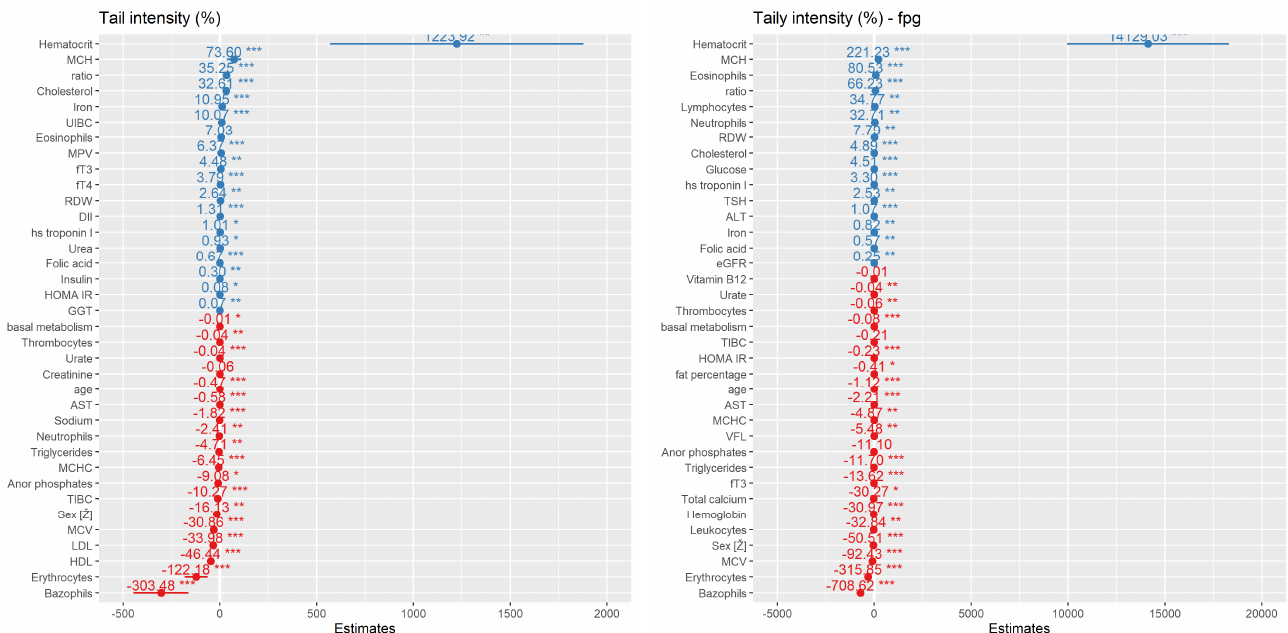
Figure 7. Stepwise regression model for DNA damage prediction of tail intensity (TI, %) values in alkaline comet and Fpg comet assay for obese group of people with BMI ≥ 35 kg m − 2 based on the biochemical and anthropometric parameters used in the study. Values are categorized by coefficient estimates for TI value prediction, while p values reflect the importance of each variable for model prediction. Negative values have negative correlation (red) and positive values have positive correlation with TI (blue) *— p -value < 0.05, **— p -value < 0.01, ***— p -value <